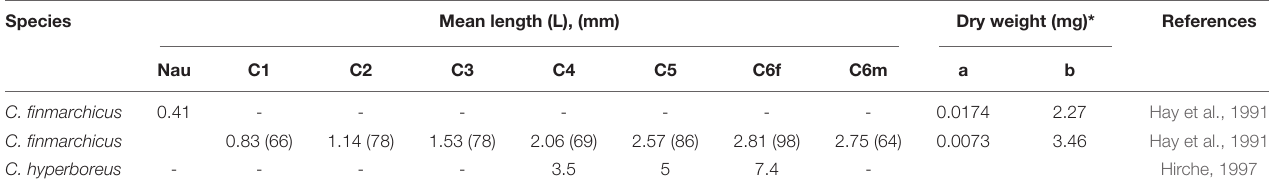
TABLE 1 | Mean length and regression coefficients (a) and exponents (b) for converting length (mm) to dry weight (mg) of dominant prey species in the environment and in the herring stomach content. Species Mean length (L), (mm)